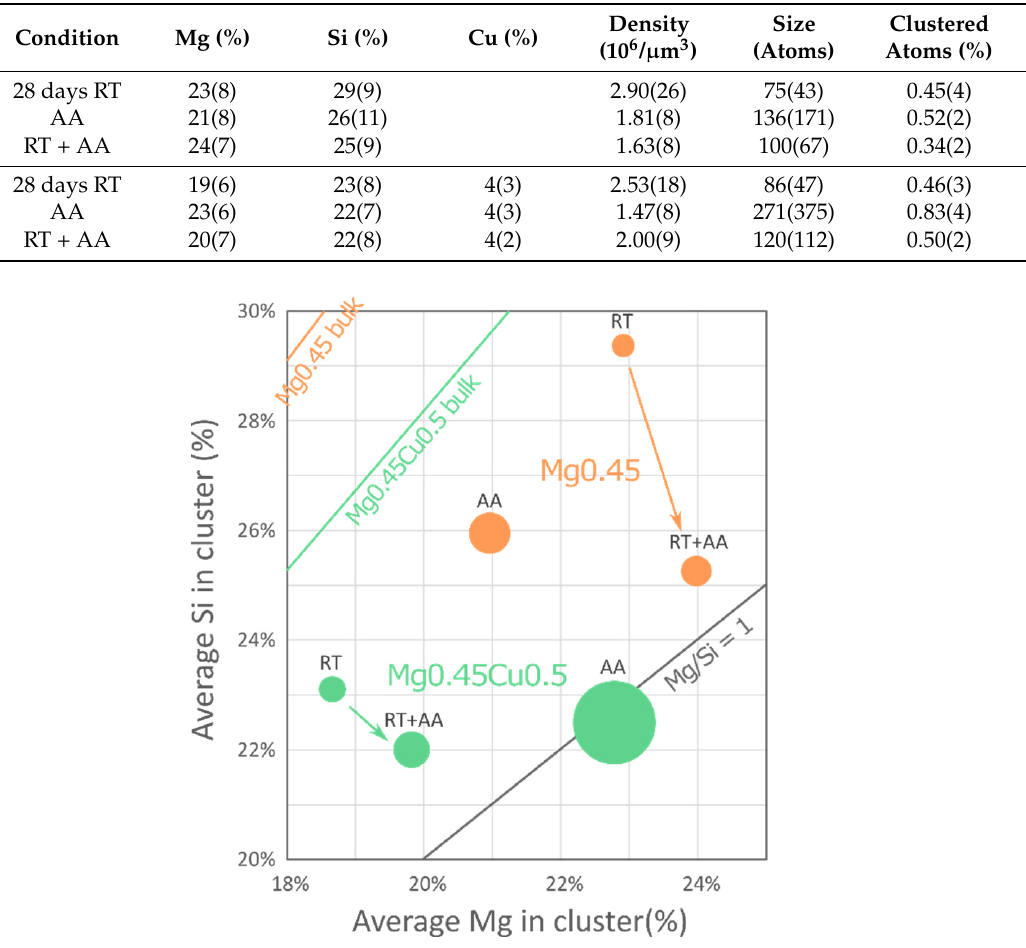
Figure 5. Average cluster compositions from APT as tabulated in Table 3. The circle radii are scaled with the average cluster size. Lines are shown for constant Mg/Si ratios, with the “bulk” lines being the ratio of the average composition of the three analyzed volumes for each alloy (from Table 2), corresponding to the composition of the Al grains.